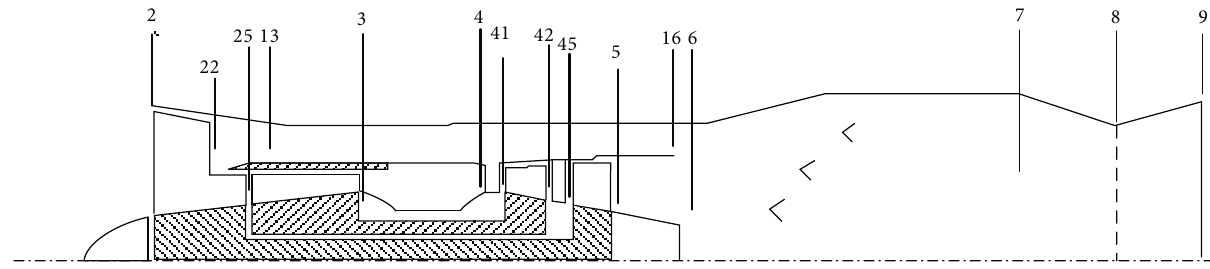
Figure 2: Turbofan engine structure diagram.